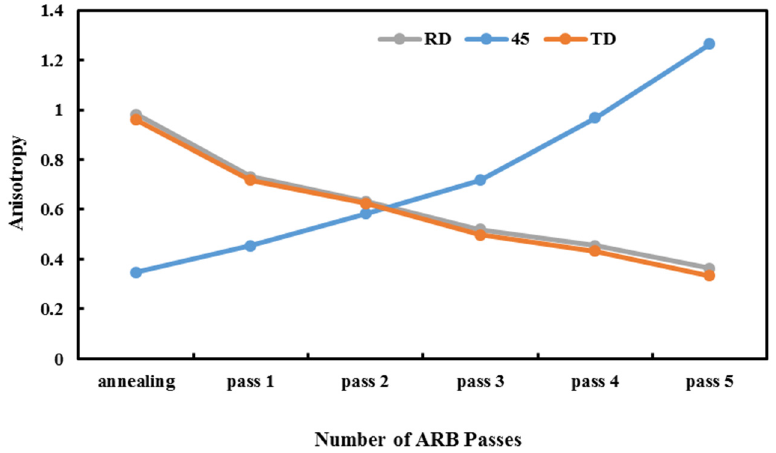
Figure 9. The anisotropy (Lankford coefficient) of the annealed sample and ARBed samples (1–5) in three rolling directions: 45-degree, RD, TD.